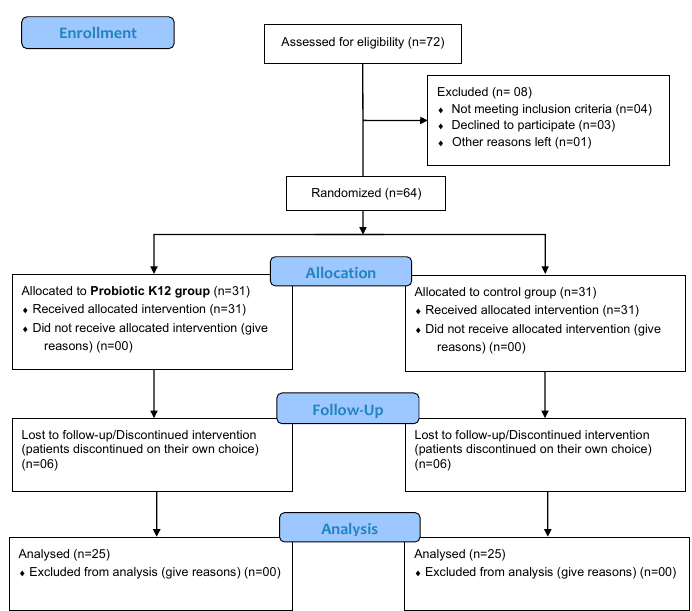
Figure 1. Protocol scheme adopted for the study.